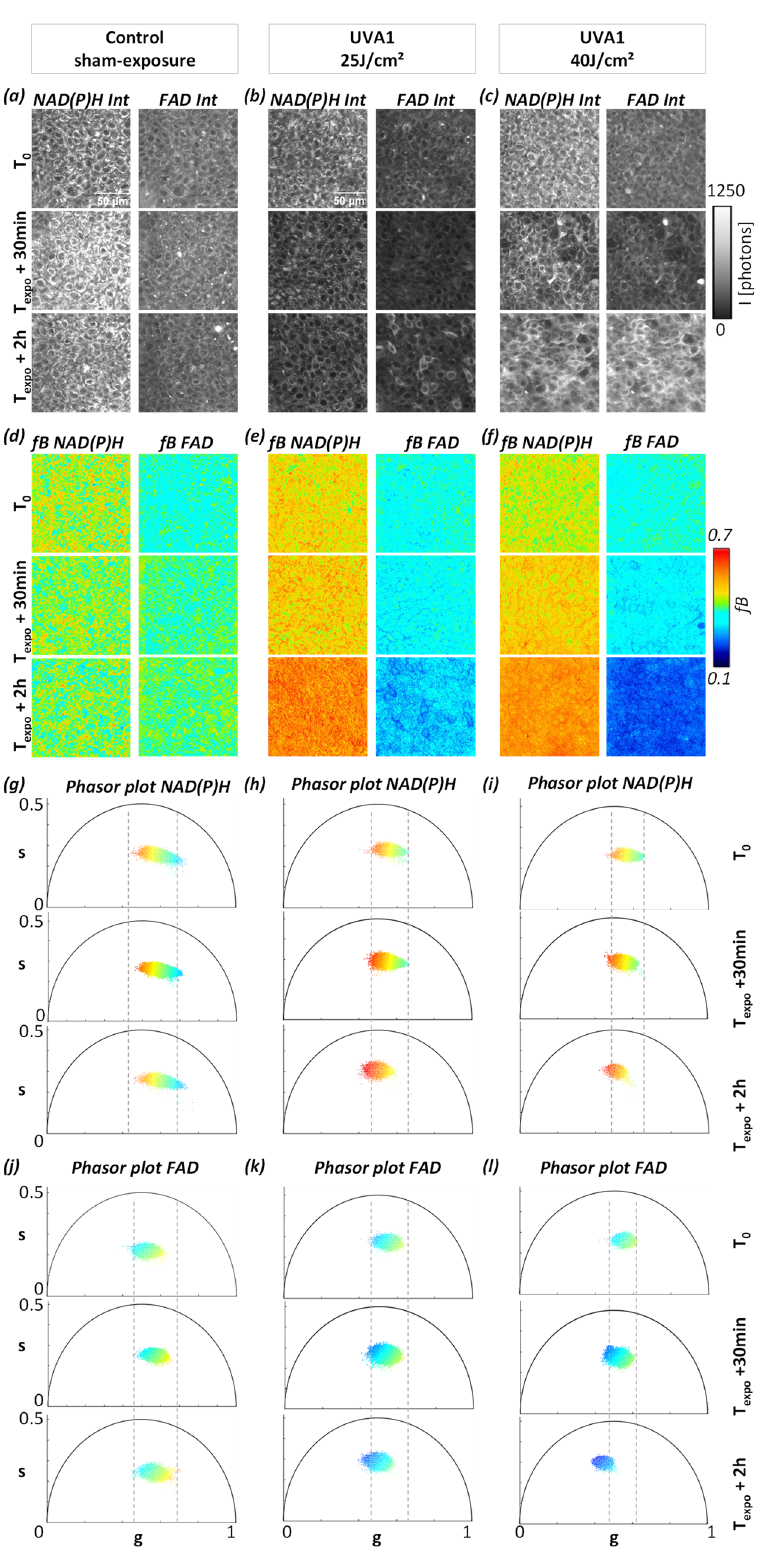
Figure 3. Temporal dynamic of UVA1 dose effects on NAD(P)H and FAD metabolic biomarkers in basal keratinocytes of reconstructed human skin. Representative images of ( a – c ) NAD(P)H and FAD fluorescence intensities and ( d – f ) f B fractions of bound NAD(P)H and FAD acquired before (T 0 ), at 30 min (T expo + 30 min) and 2 h (T expo + 2 h) post sham-exposure (Control) or UVA1 exposure at 25 J/cm 2 and 40 J/cm 2 . ( g – i ) Representative phasor plot scatters of NAD(P)H and ( j – l ) FAD fluorescence lifetime data of the same samples at T 0 , T expo + 30 min and T expo + 2 h. Every pixel of the phasor plot is color coded according to the fraction of bound metabolites with the same look up table as for images ( d )–( f